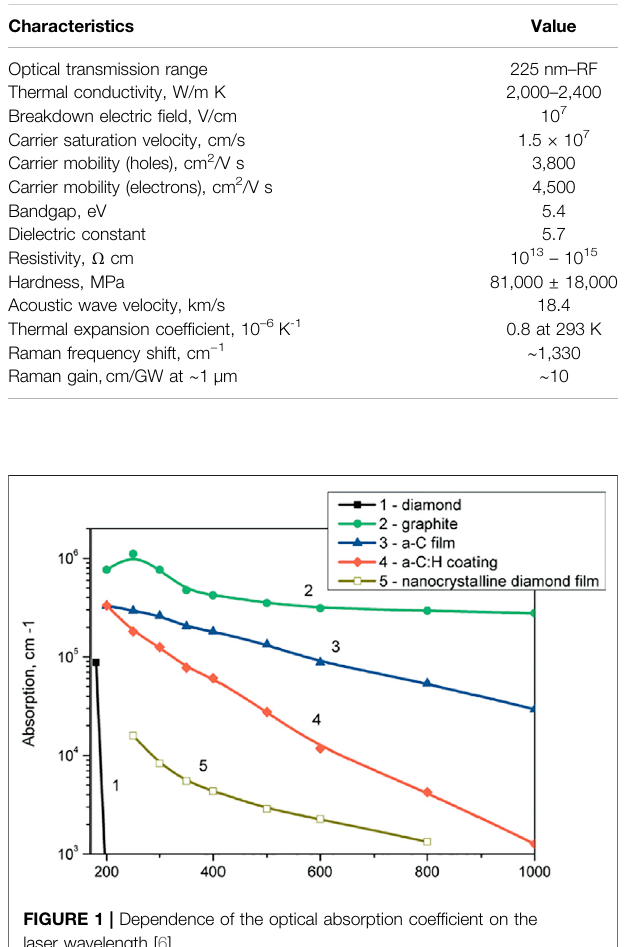
TABLE 1 | Basic characteristics of diamonds.